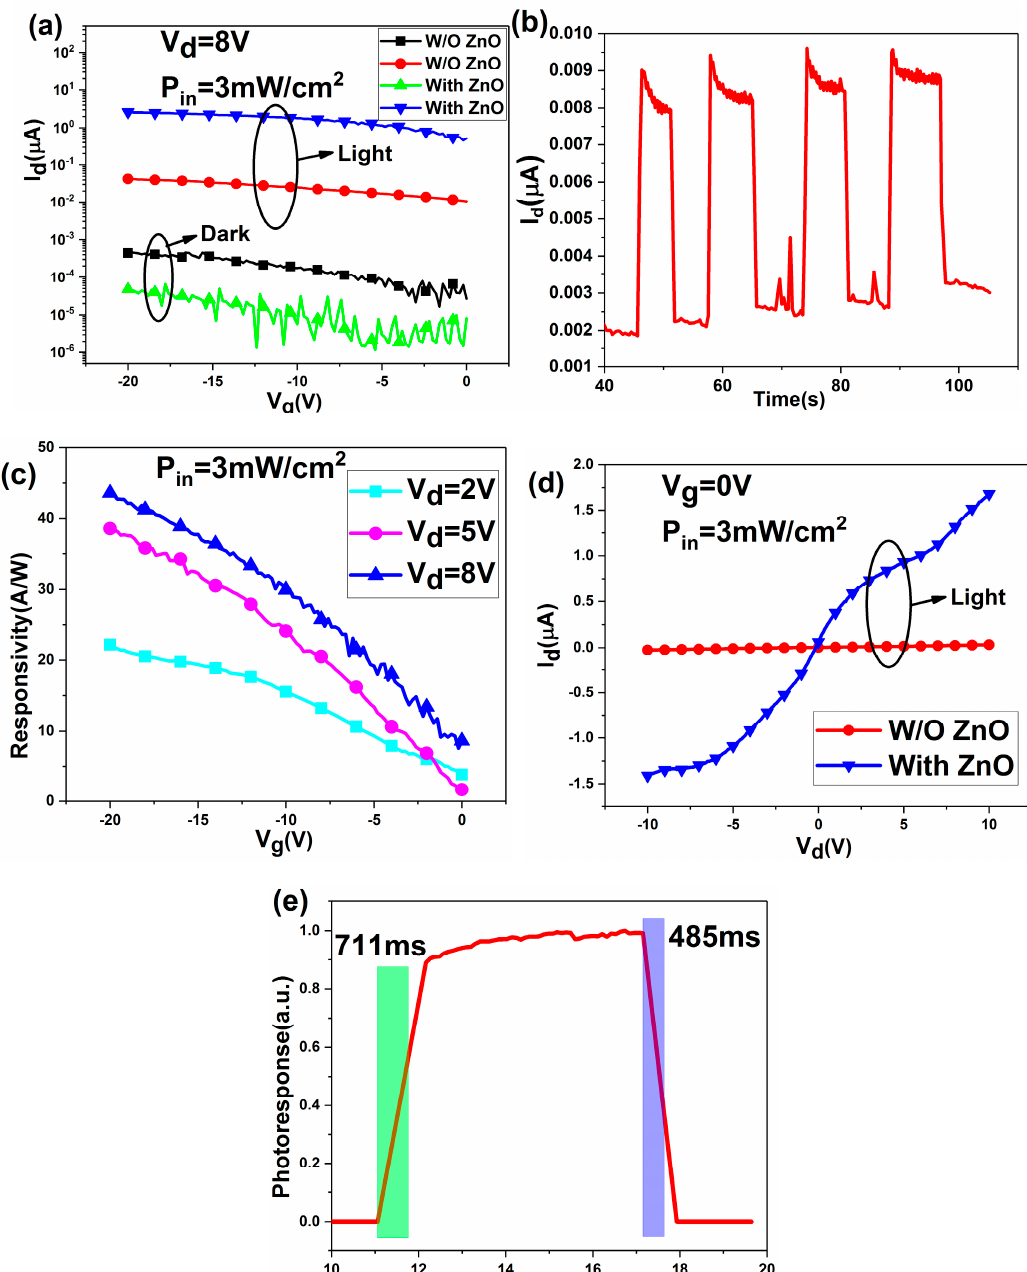
Figure 5. ( a ) Transfer characteristic curves of with and without ZnO QDs film phototransistors with and without 365 nm LED illumination (3 mW / cm 2 ). Vd = 8 V. ( b ) The I-T curve of the device with single ZnO QDs film with 365 nm LED illumination (3 mW / cm 2 ), V g = -20 V, V d = 8 V. ( c ) The response of the With ZnO device as a function of V g and V d . ( d ) Output characteristic curves of with and without ZnO QDs film phototransistors with 365 nm LED illumination (3 mW / cm 2 ), V g = 0V. ( e ) Photoresponse curve for rise and decay time.